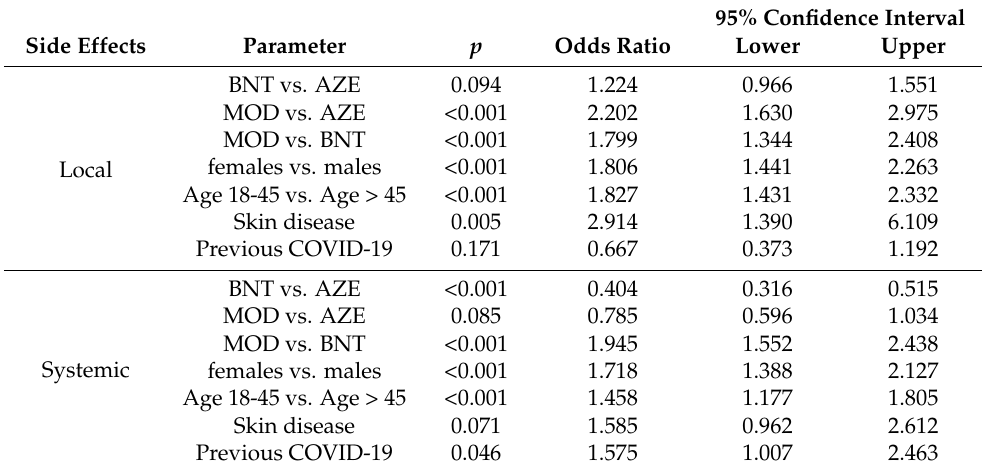
Table 7. Generalized linear model across all vaccination instances (V1, V2 and V3) for local and systemic SE.